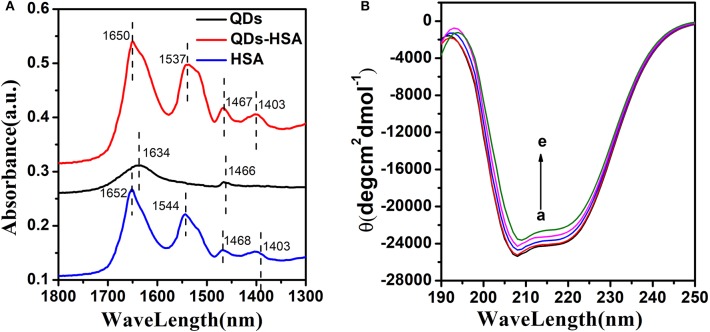
(A) FT-IR spectra of HSA, AIZS-GO QDs, and AIZS-GO QDs-HSA system. (B) CD spectra of HSA with different concentration AIZS-GO QDs. c(HSA) = 1.0 × 10−6molL−1, c(AIZS-GO QDs): (a-e): 0, 2, 4, 6, 8 × 10−6molL−1. pH = 7.4.